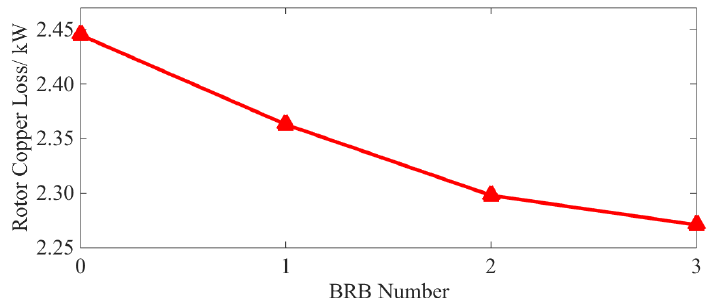
Figure 10. Characteristic curve of rotor copper loss.